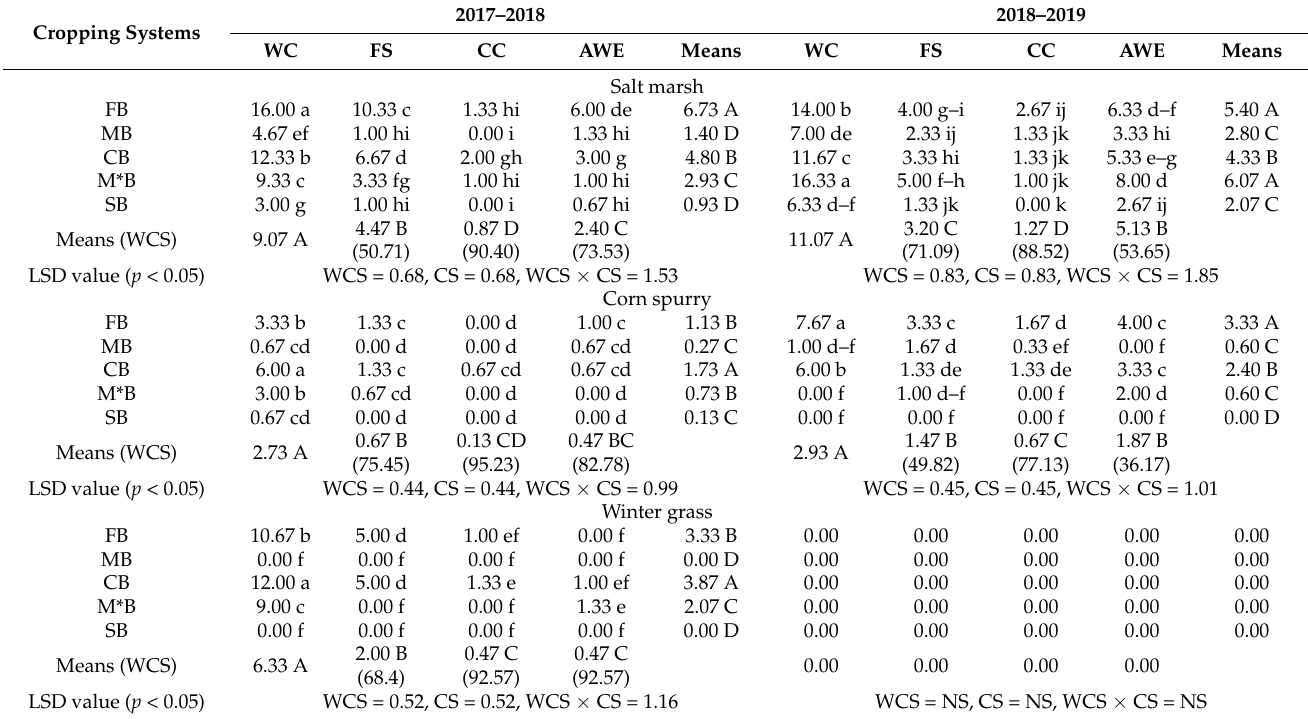
Table 3. Influence of different barley-based cropping systems on individual density (m − 2 ) of grassy weed species under various weed management methods during 2017–2018 and 2018–2019. Cropping Systems